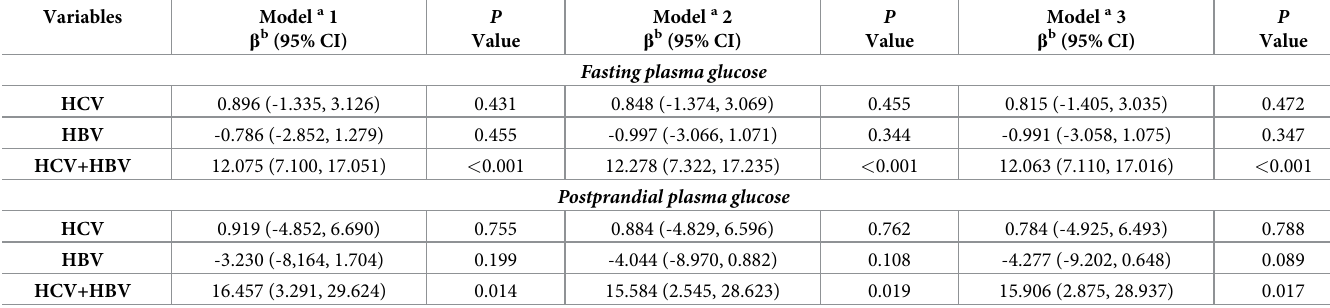
Table 4. Association between hepatic infection and FPG and PPG.